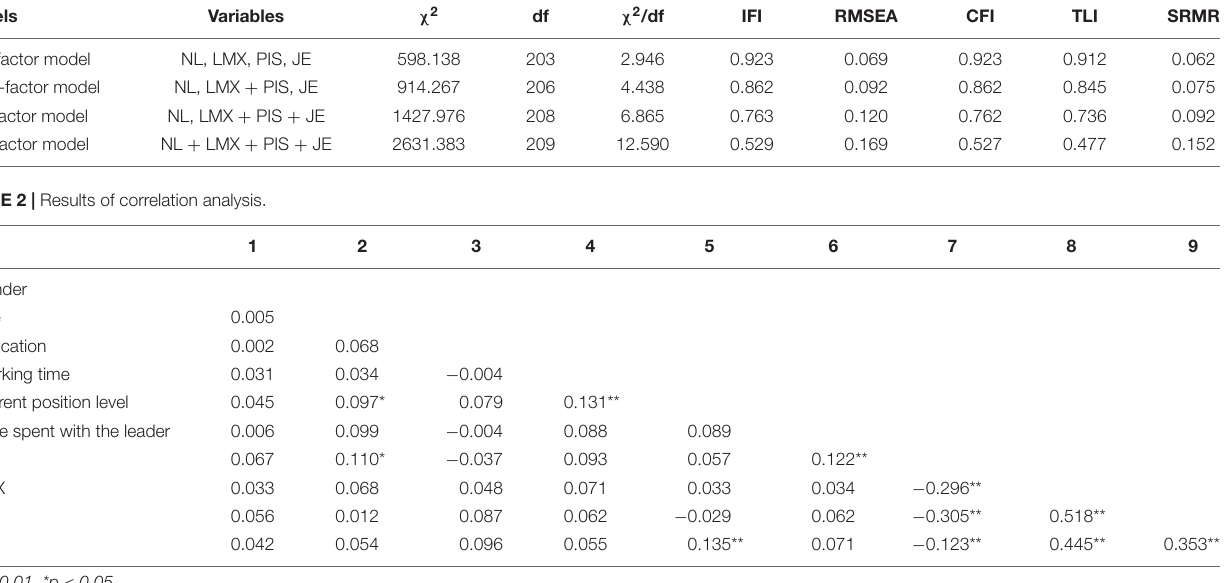
TABLE 1 | Results of confirmatory factor analyses.